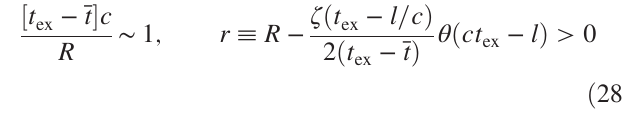
FIG. 4. Normalized charge density plot 1 − n same conditions as in Fig. 7 after about 25 fs (up) and 70 fs (down), i.e. resp. before and after the maximal penetration time ¯ t ð 0 Þ ¼ 51 fs; in the latter picture the electrons travelling back- wards make light yellow-blue striped the region between the yellow and the white-blue striped